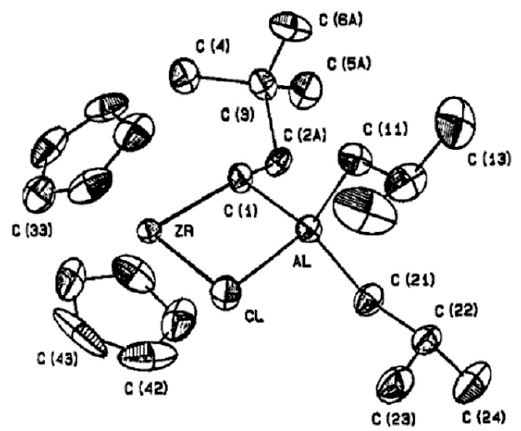
Figure 15. Molecular structure of complex Zr16 . Reprinted with permission from [155]. Copyright (1987) American Chemical Society.